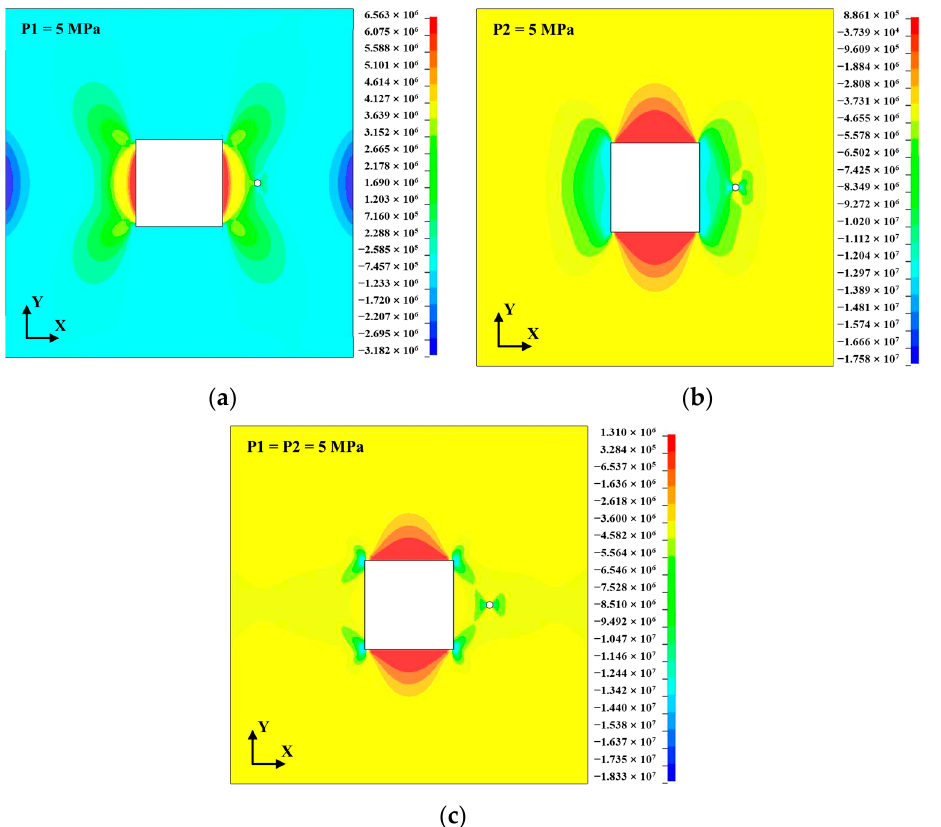
σ ) under different static loads ( W = 4 cm): ( a ) P1 = 5 y